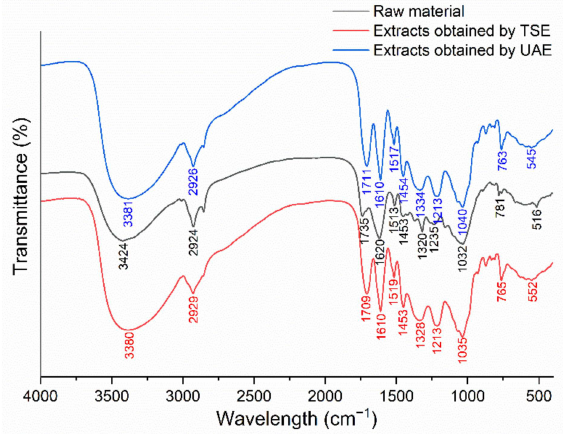
Figure 7. FTIR spectrum analysis of the raw materials and extracts obtained by UAE and